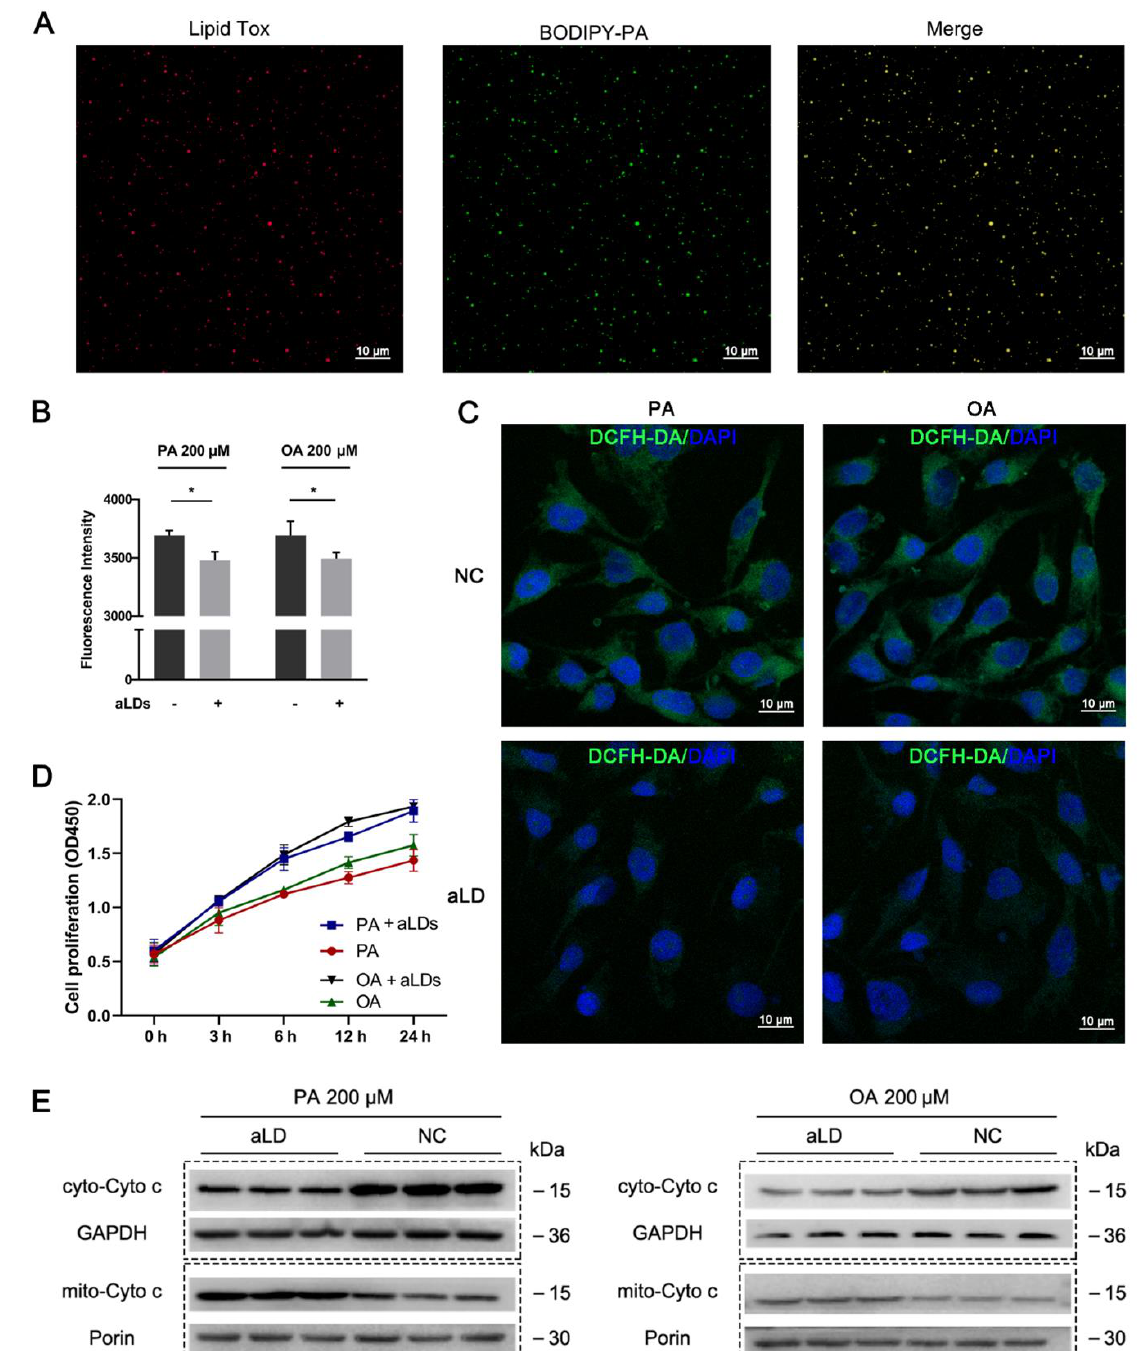
Figure 5. Fatty acid absorption and alleviation of lipotoxicity. ( A ) Detection of BODIPY-PA Localiza- tion. Scale bar: 10 µ m. ( B ) Detection of ROS after PA/OA treatment in Hela cell. Data are presented as mean ± SD ( n = 3). * p < 0.05. Scale bar: 10 µ m. ( C ) Observation of ROS after PA/OA treatment in Hela cell. NC: Hela cells were not incubated with aLDs. Scale bar: 10 µ m. ( D ) Detection of cell proliferation of cell after PA/OA treatment. ( E ) Detection of cyto-C release from mitochondria after PA/OA